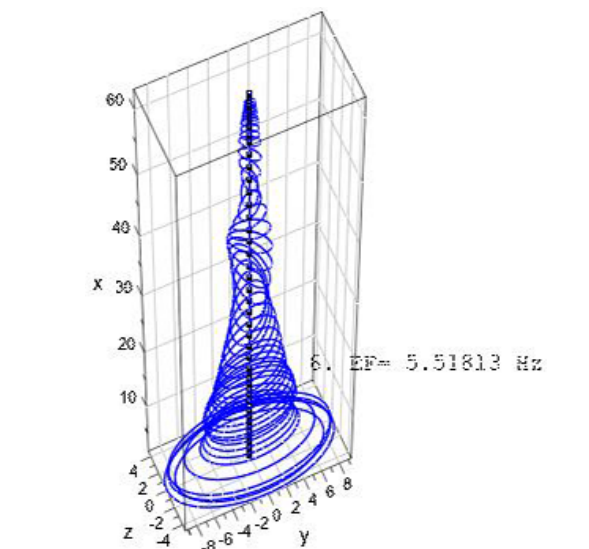
Figure 9. First torsional eigenmode.